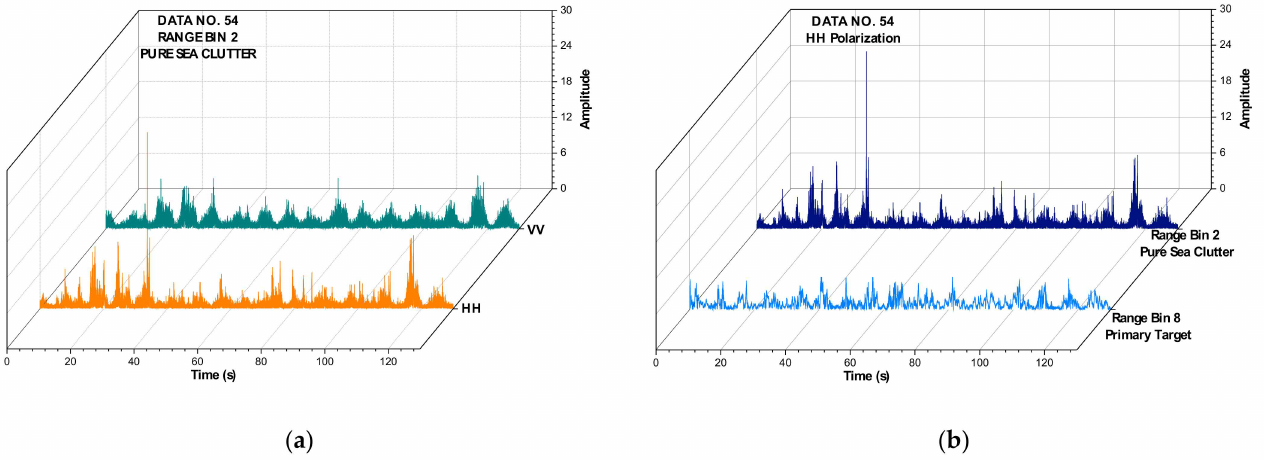
Figure 3. Backscattering amplitudes of some range bins in data set 54: ( a ) pure sea clutter, and HH and VV polarization and ( b ) and primary target, and pure sea clutter and HH